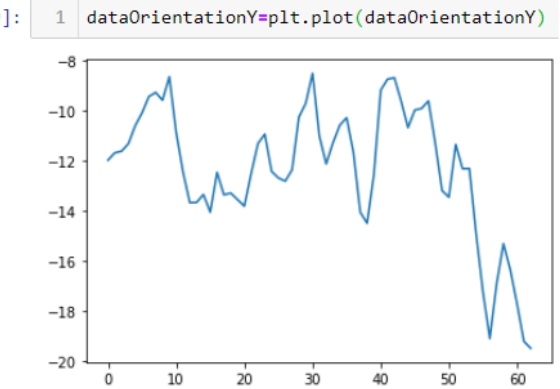
Figure 53. Orientation of the user between −12 and −20, i.e., between north and west. The functions dataOrientationZ=dataOrientation[“Z”] and dataOrientationZ=plt.plot (dataOrientationZ ) were then used to display the z -axis orientation Figure 54. Here, fluctuations between 3 and −4 could be observed.